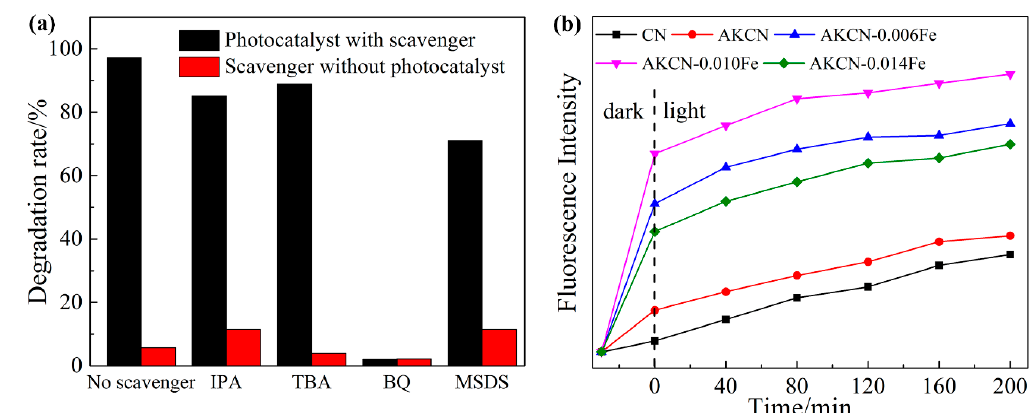
Figure 8. ( a ) Survival curves of P. aeruginosa as a function of the as-prepared semiconductor photocatalysts under visible light and ( b ) photocatalytic antibacterial rate histogram towards P. aeruginosa, E. coli , and S. aureus under visible light. ( c ) TEM images of the P. aeruginosa, E. coli , and S. aureus cell before and after photocatalytic reaction.